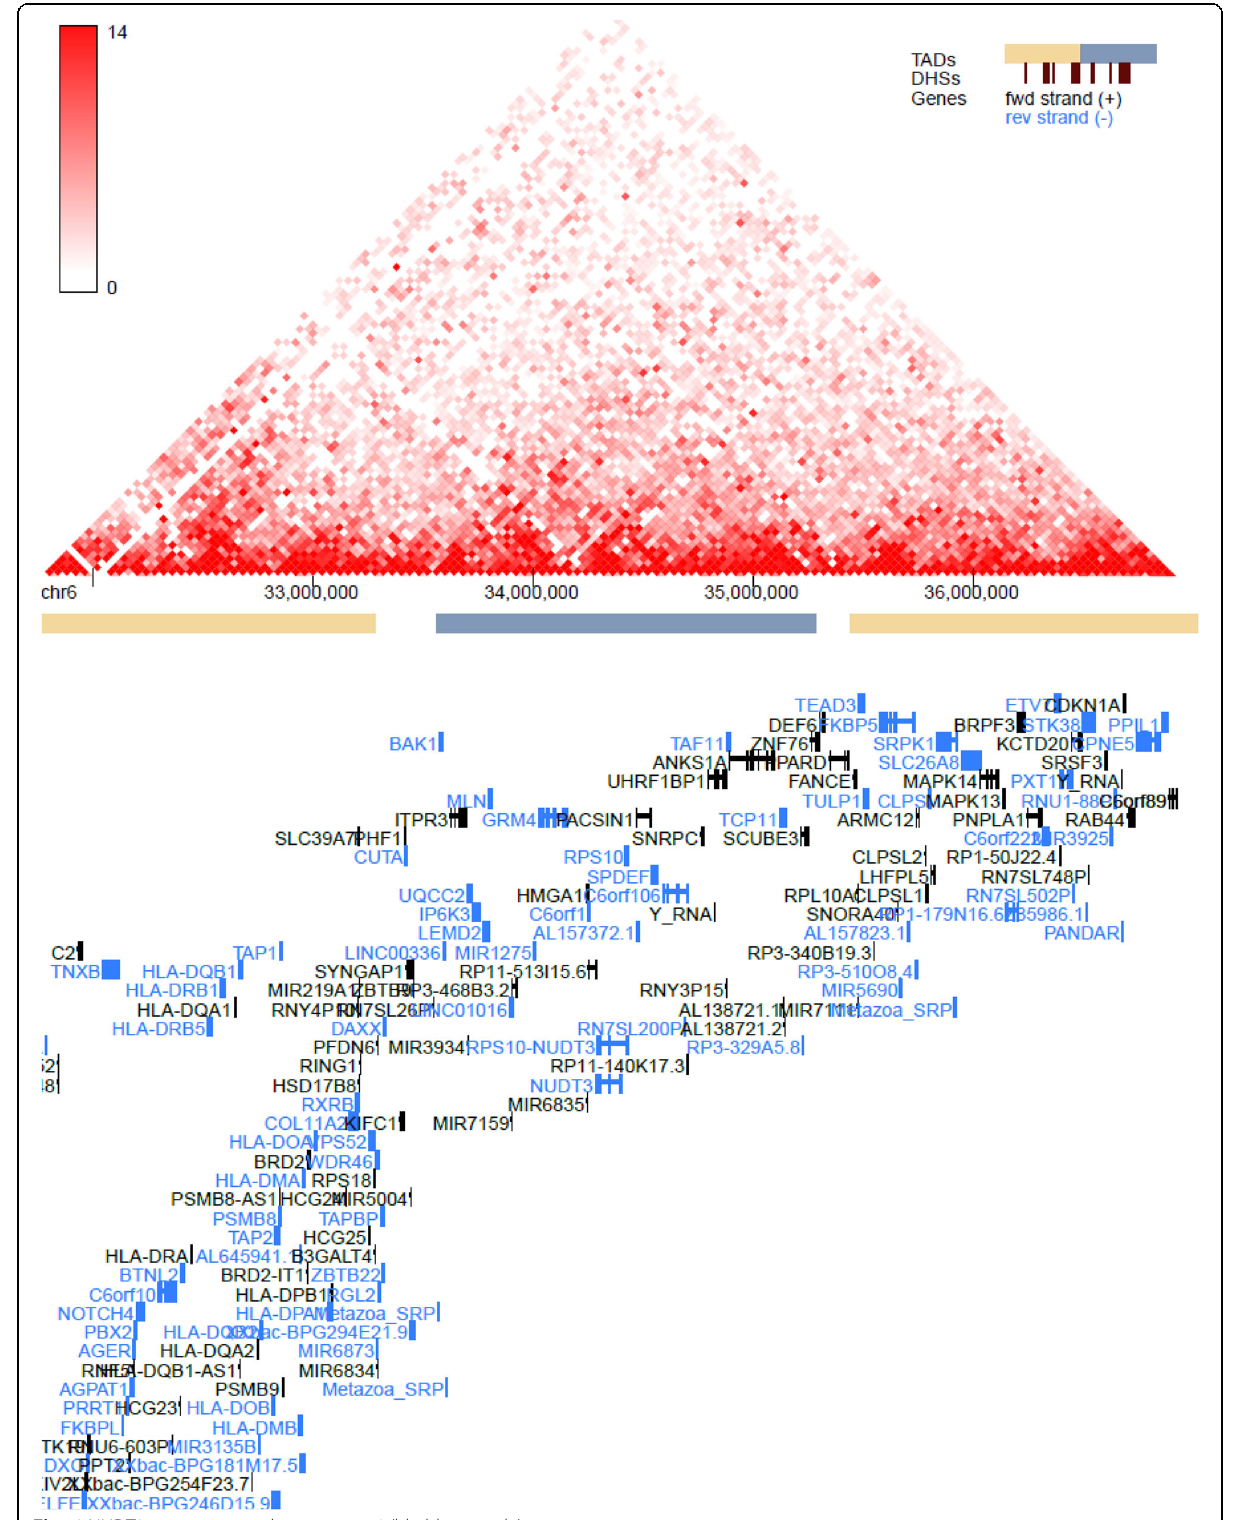
Fig. 6 NUDT3 expression in chromosome 6 (bladder